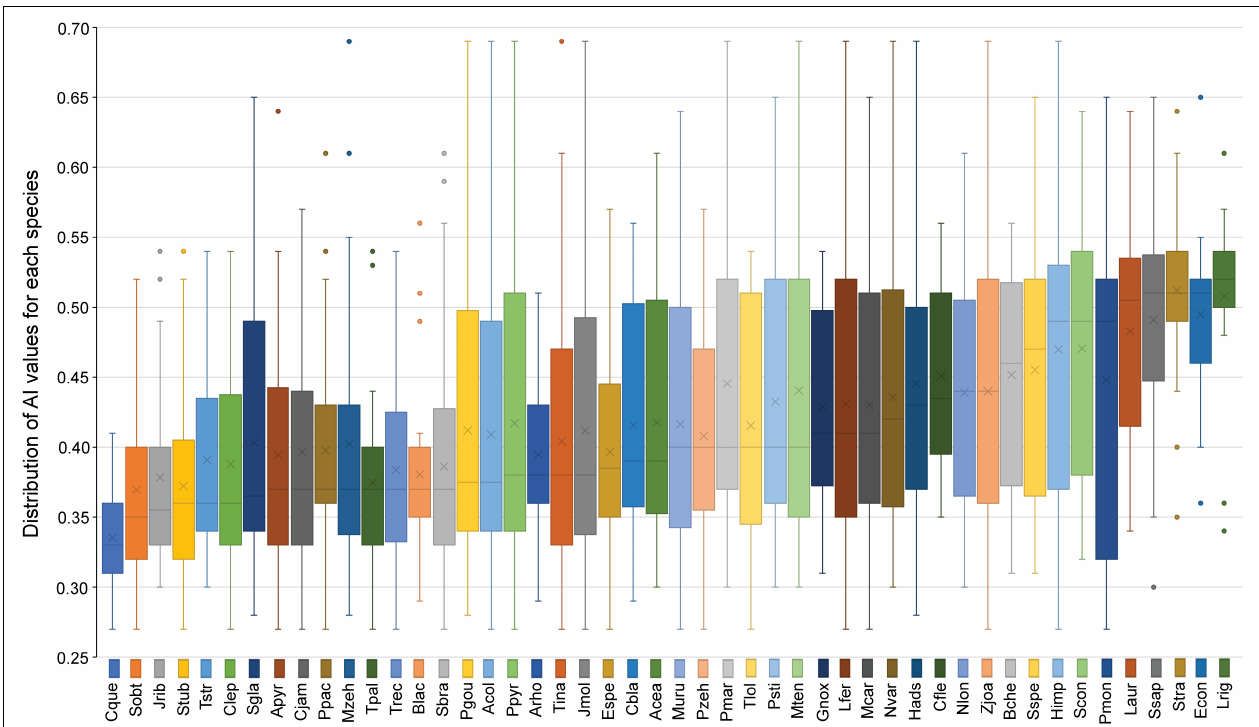
FIGURE 3 | Boxplots showing the minimum, lower quartile, median, upper quartile and the maximum values of the aridity index of the sampling units where the presence of each of the dominant species (48 species) was recorded. Species are arranged in ascending order of the median of the aridity index values found along their distribution range. Abbreviated species’ names from left to right in the Figure: Cque ( Cnidoscolus quercifolius ), Sobt ( Sideroxylon obtusifolium ), Jrib ( Jatropha ribifolia ), Stub ( Spondias tuberosa ), Tstr ( Tillandsia streptocarpa ), Clep ( Commiphora leptophloeos ), Sgla ( Sapium glandulosum ), Apyr ( Aspidosperma pyrifolium ), Cjam ( Cereus jamacaru ), Ppac ( Pilosocereus pachycladus ), Mzeh ( Melocactus zehntneri ), Tpal ( Tacinga palmadora ), Trec ( Tillandsia recurvata ), Blac ( Bromelia laciniosa ), Sbra ( Schinopsis brasiliensis ), Pgou ( Xiquexique gounellei subsp. gounellei ), Acol ( Anadenanthera colubrina ), Ppyr ( Cenostigma pyramidale var. pyramidale ), Arho ( Arrojadoa rhodantha ), Tina ( Tacinga inamoena ), Jmol ( Jatropha mollissima ), Espe ( Encholirium spectabile ), Cbla ( Croton blanchetianus ), Acea ( Amburana cearensis ), Muru ( Astronium urundeuva ), Pzeh ( Parapiptadenia zehntneri ), Pmar ( Pseudobombax marginatum ), Tlol ( Tillandsia loliacea ), Psti ( Piptadenia stipulacea ), Mten ( Mimosa tenuiflora ), Gnox ( Guapira noxia ), Lfer ( Libidibia ferrea ), Mcar ( Manihot carthagenensis ), Nvar ( Neoglaziovia variegata ), Hads ( Harrisia adscendens ), Cfle ( Cynophalla flexuosa ), Nlon ( Neocalyptrocalyx longifolium ), Zjoa ( Sarcomphalus joazeiro ), Bche ( Bauhinia cheilantha ), Sspe ( Senna spectabilis ), Himp ( Handroanthus impetiginosus ), Scon ( Selaginella convoluta ), Pmon ( Pityrocarpa moniliformis ), Laur ( Luetzelburgia auriculata ), Ssap ( Sapindus saponaria ), Stra ( Senna trachypus ), Econ ( Enterolobium contortisiliquum ), and Lrig ( Microdesmia rigida